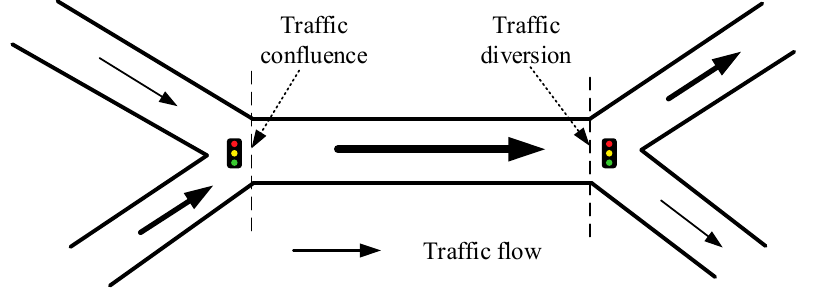
Figure 2. Schematic diagram of the diversion and confluence mechanism of urban road intersections.